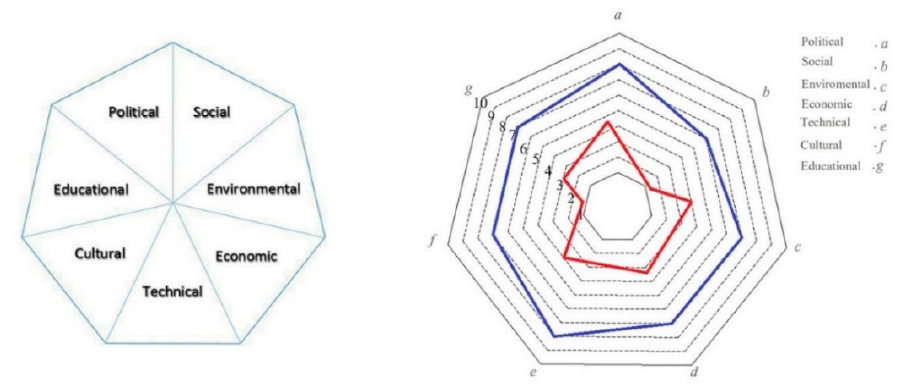
Figure 1. 7 PS Model [7–9] .